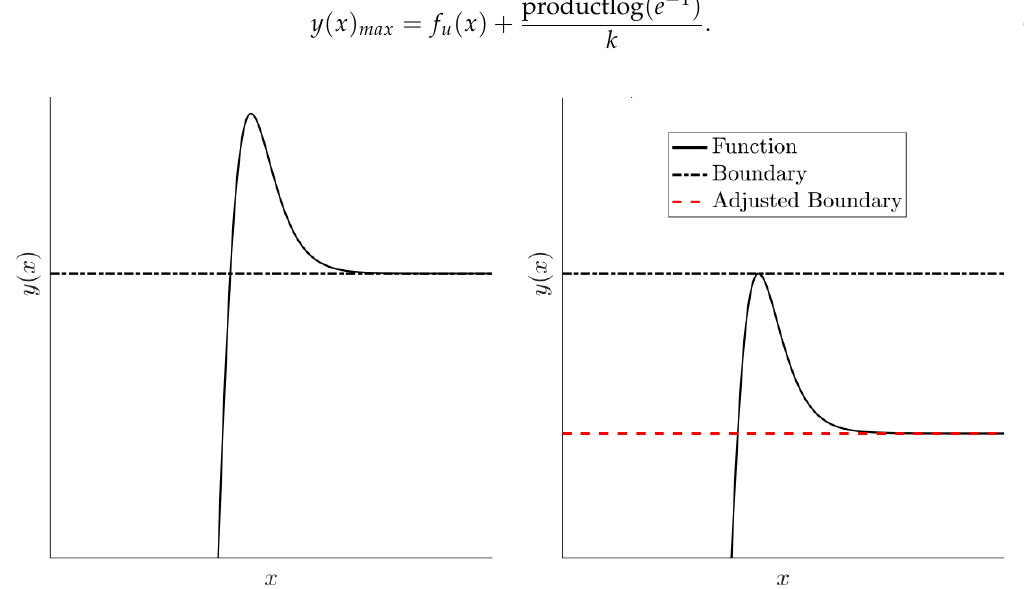
Figure 6. Overshoot of y ( x ) for the upper bound constraint. This phenomenon can be quantified and can be used to eliminate the